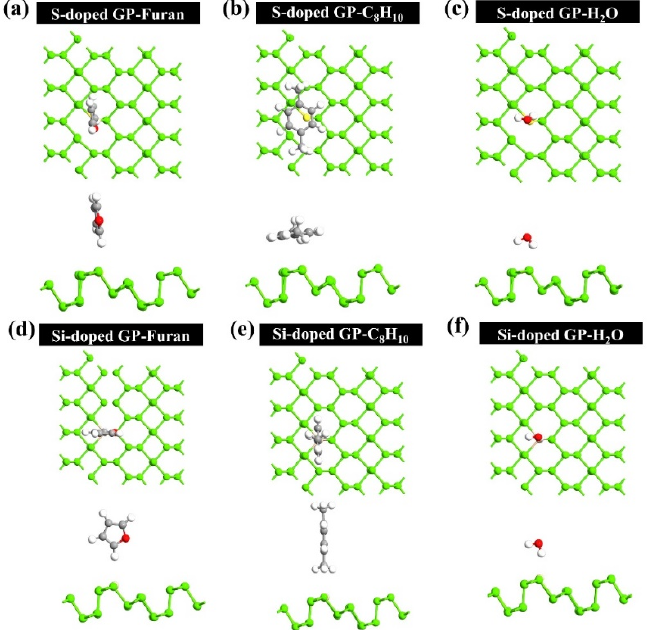
Figure 5. The most relaxed structures for adsorption of molecules on the S-doped and Si-doped GP surface. Configurations of S-doped ( a ) furan ( b ) C 8 H 10 ( c ) H 2 O, and Si-doped ( d ) furan ( e ) C 8 H 10 ( f ) H 2 O.